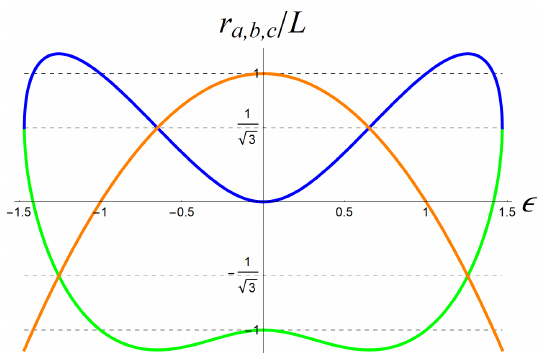
Figure 8: The roots of f ( r ) in units of L as a function of ε for d = 4. The black hole horizon radius r is shown in blue, the cosmological horizon radius r b = − ( r + r ) in the third root r a b c